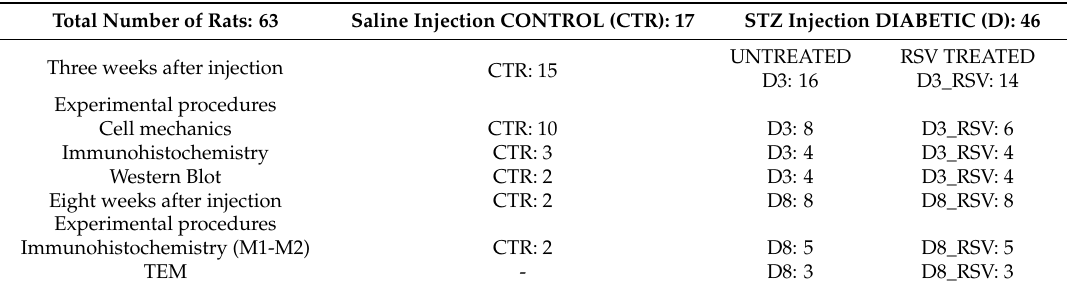
Table 2. In vivo/ex vivo study: Experimental protocol and